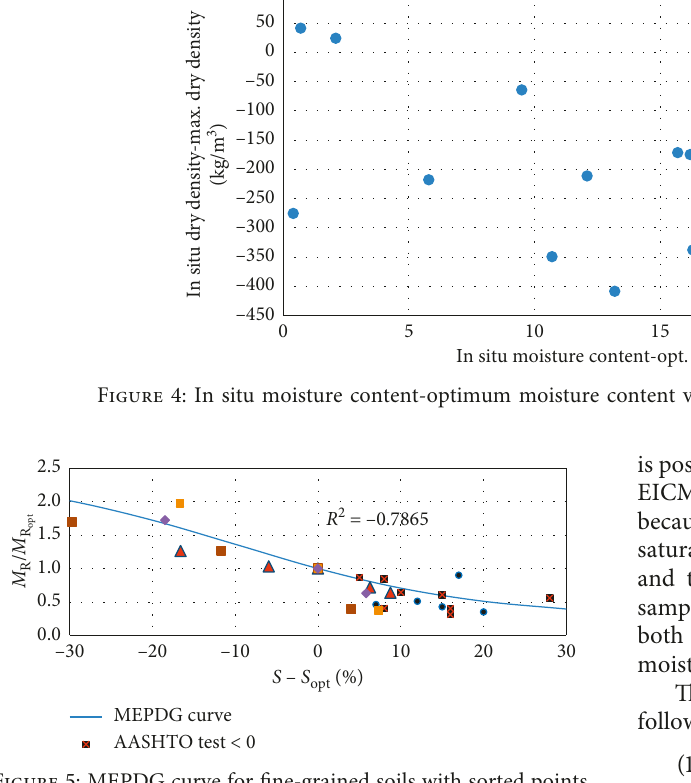
Figure 5: MEPDG curve for fine-grained soils with sorted